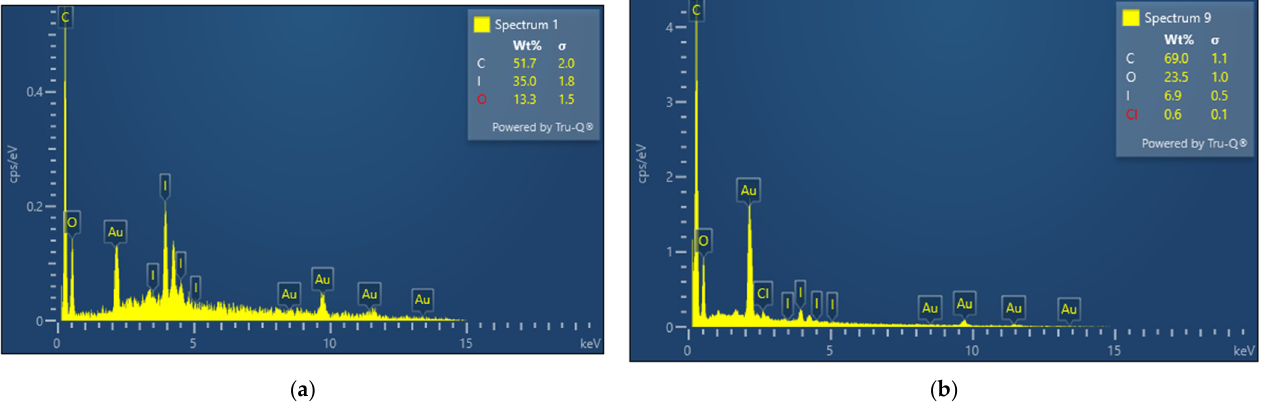
Figure 4. EDS of medical bandages impregnated with AV-PVP-TCA-I 2 : ( a ) area 1 coiled; ( b ) area 2 ordered.